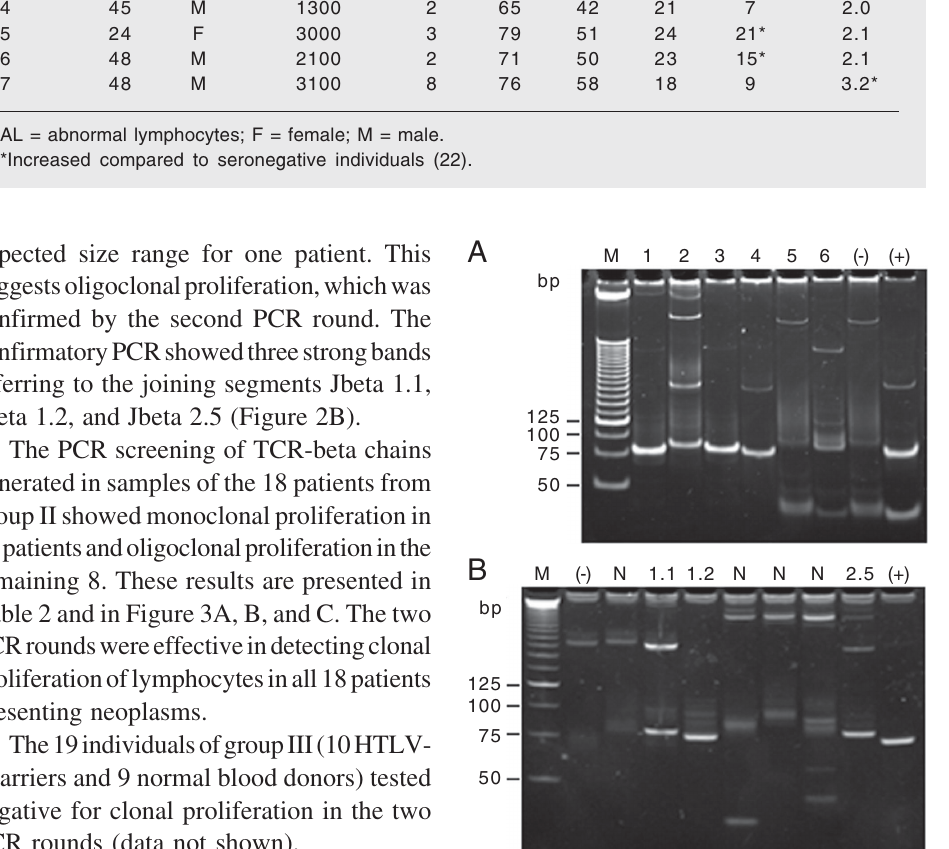
Figure 1. Schematic presenta- tion of the T-cell receptor (TCR)- beta gene and a possible pat- tern of rearrangement. In the screening PCR, the sense prim- ers (open horizontal arrows) were applied as four oligo- nucleotide mixtures, binding to all segments of the 24 variable (V) families available in GenBank and to the two diver- sity (D) beta segments. Two of the antisense primers (filled horizontal arrows) match to in- trons downstream of the Jbeta 1 and Jbeta 2 clusters (black arrows 2 and 3); the third anti- sense primer hybridizes to an intron between Jbeta 1.3 and Jbeta 1.4 (black arrow